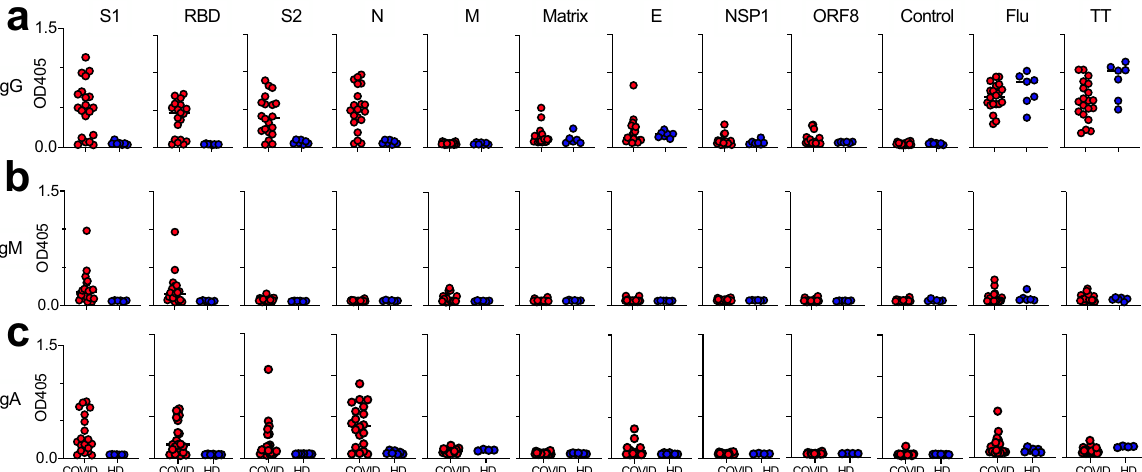
Fig. 1 Analysis of antibody responses against full-length proteins. Analyzing plasma samples from 20 patients with COVID-19 in an ELISA we observed a IgG, b IgM (middle), and c IgA responses against a restricted group of four full-length recombinant proteins of the SARS-CoV-2 virus. Full-length GST (glutathione S-transferase) protein was used as a negative control and In fl uenza A nucleoprotein (Flu) and tetanus toxoid (TT) proteins served as positive controls. Dots indicate resulting OD values of patients (red) vs 7 healthy controls (blue). Asterisks indicate statistical signi fi cance of differences as determined by unpaired two-tailed Student ’ s t test. * p < 0.05; ** p < 0.01; *** p < 0.001; ns: not signi fi